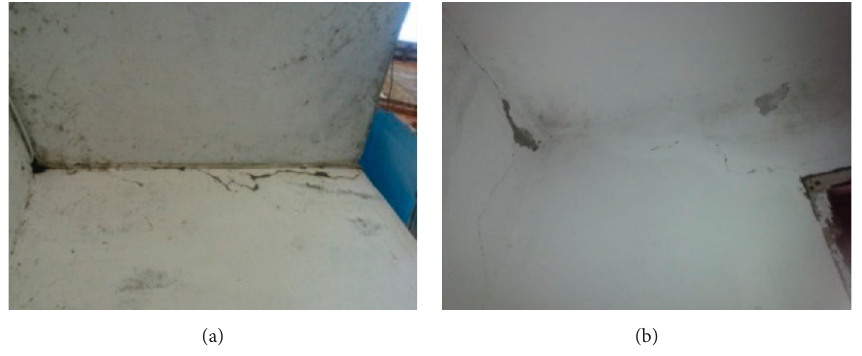
Figure 4: Cracks of the stress concentrated area.